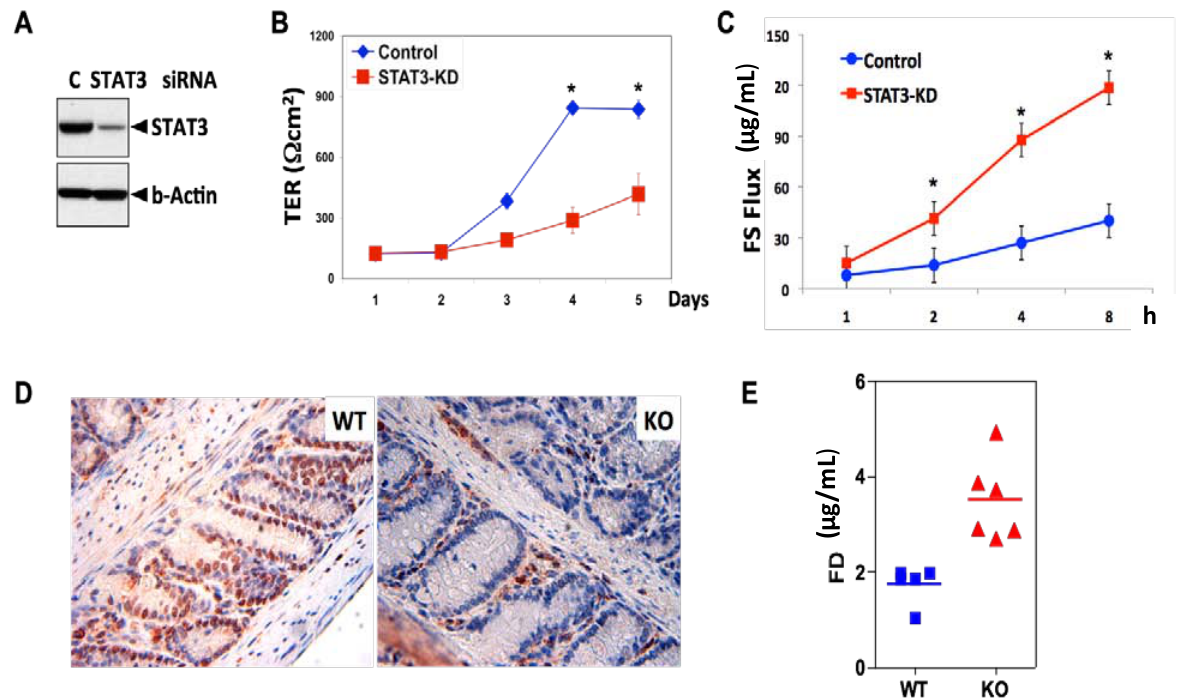
Figure 2. STAT3 promotes polarization and barrier function of IEC in vitro and in vivo . ( A ) STAT3 in HCA-7 cells was silenced by RNAi and the indicated proteins were measured by immunoblotting; ( B ) Cells transfected with the indicated siRNA were plated on a Transwell plate and transepithelial electrical resistance (TER) was measured at the indicated time. ( n = 6) (* represents p value < 0.05, ANOVA); ( C ) The barrier function of HCA-7 cells was assessed by using FITC-sulfonic acid (FS). FS was measured five days after transfection ( n = 6); ( D ) The deletion of STAT3 IEC in mice was confirmed by immunohistochemistry (IHC) as described [37]. STAT3 staining (brown) in the KO mice is confined to mononuclear cells in the LP (Lamina Propria) but is absent in IEC; ( E ) Intestinal permeability of KO mice is significantly higher than that of WT mice ( p = 0.001). Mice were gavaged with FITC-dextran (FD, MW 4000, 6 mg/mouse) and the level of FD in serum was measured 90 min post